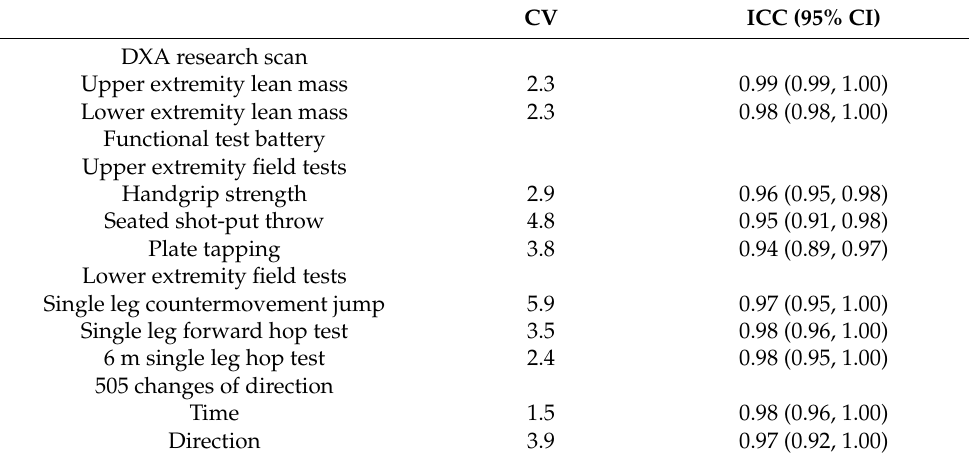
Table 2. Variability and reliability of the DXA research scans and the unilateral tests of the functional test